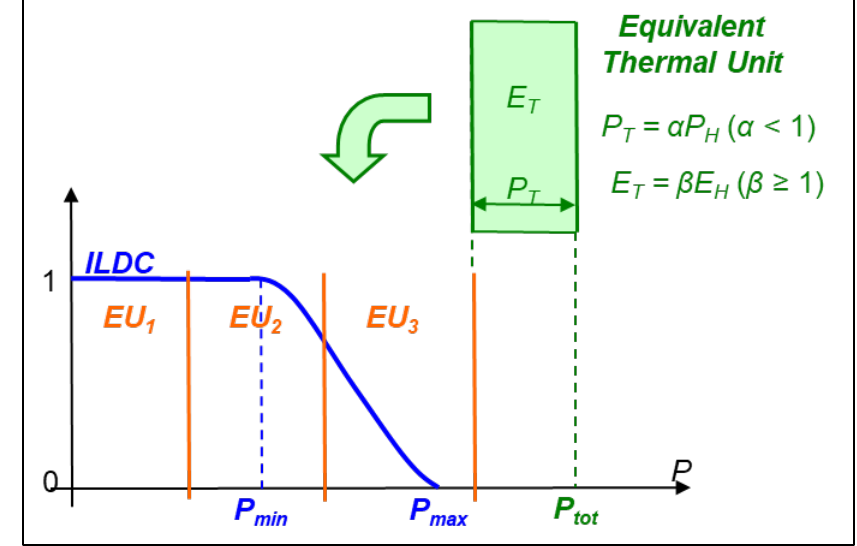
Figure 11. Fitting the equivalent thermal unit in the LDC.